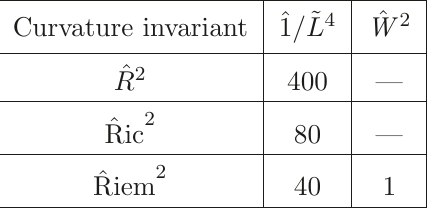
Table 1 . 5D basis of quadratic curvature invariants.